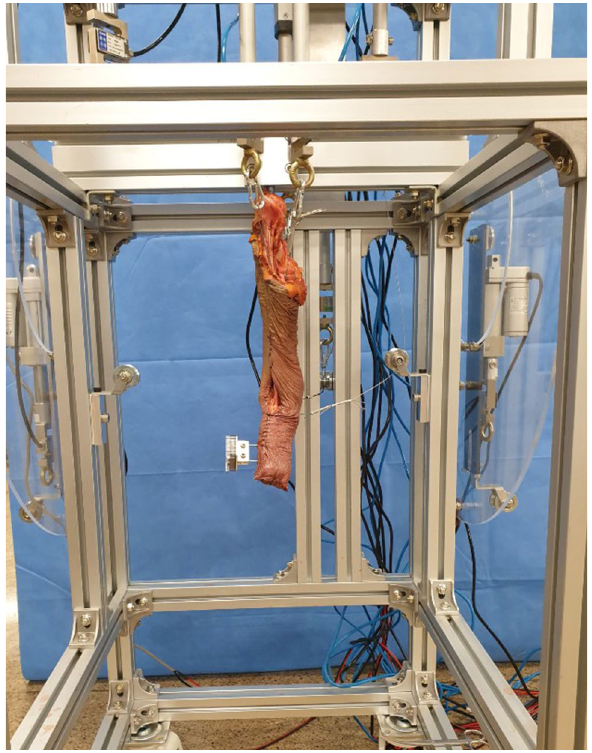
Figure 3. A transradial amputation was performed on each of the ten upper limb specimens. The amputations were performed 5 cm proximal to the radial styloid process.